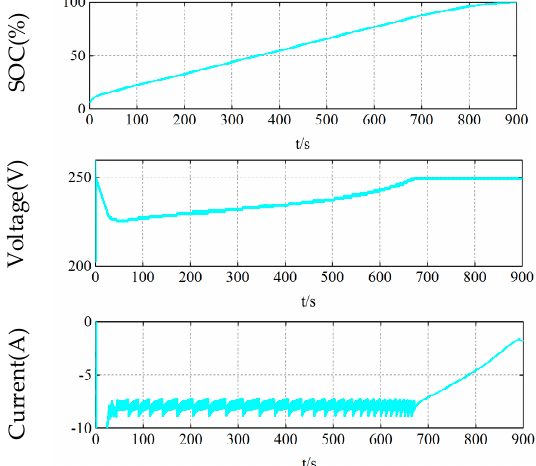
Figure 12. The characteristic curve of the primary side impedance control.